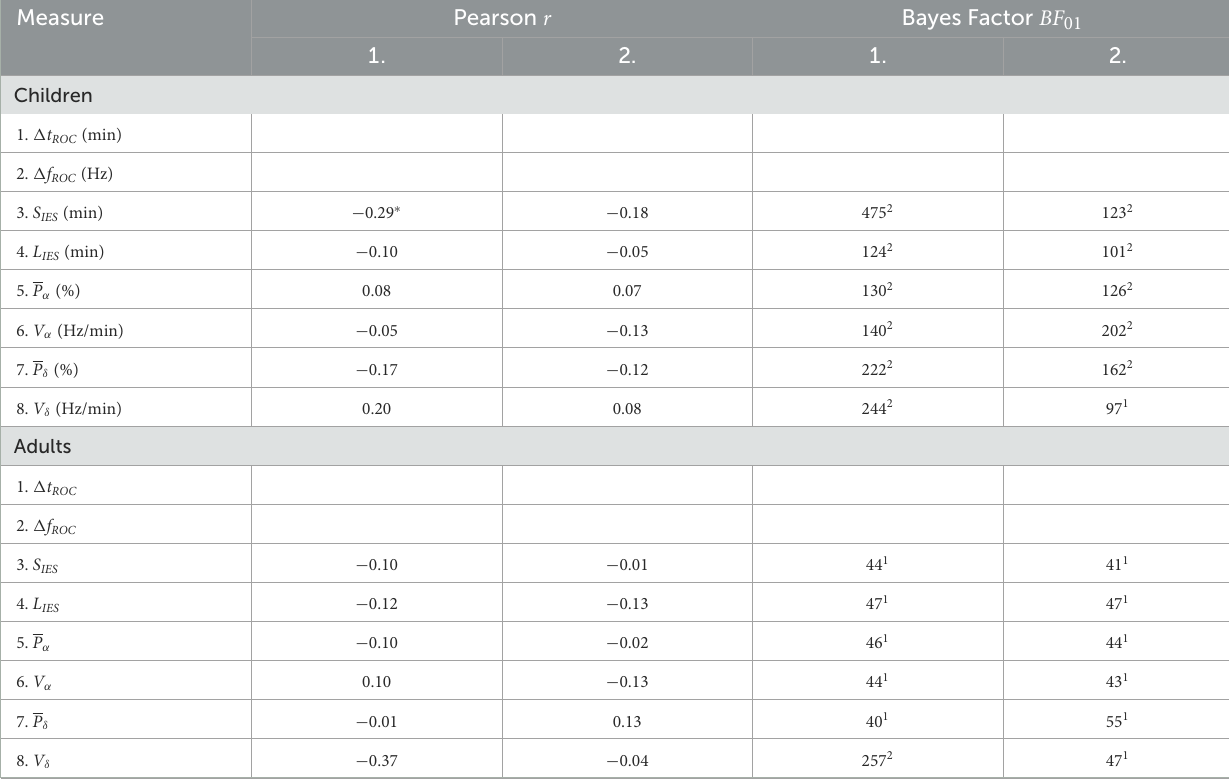
TABLE 3 Partial correlations and Bayes factor of EEG statistical